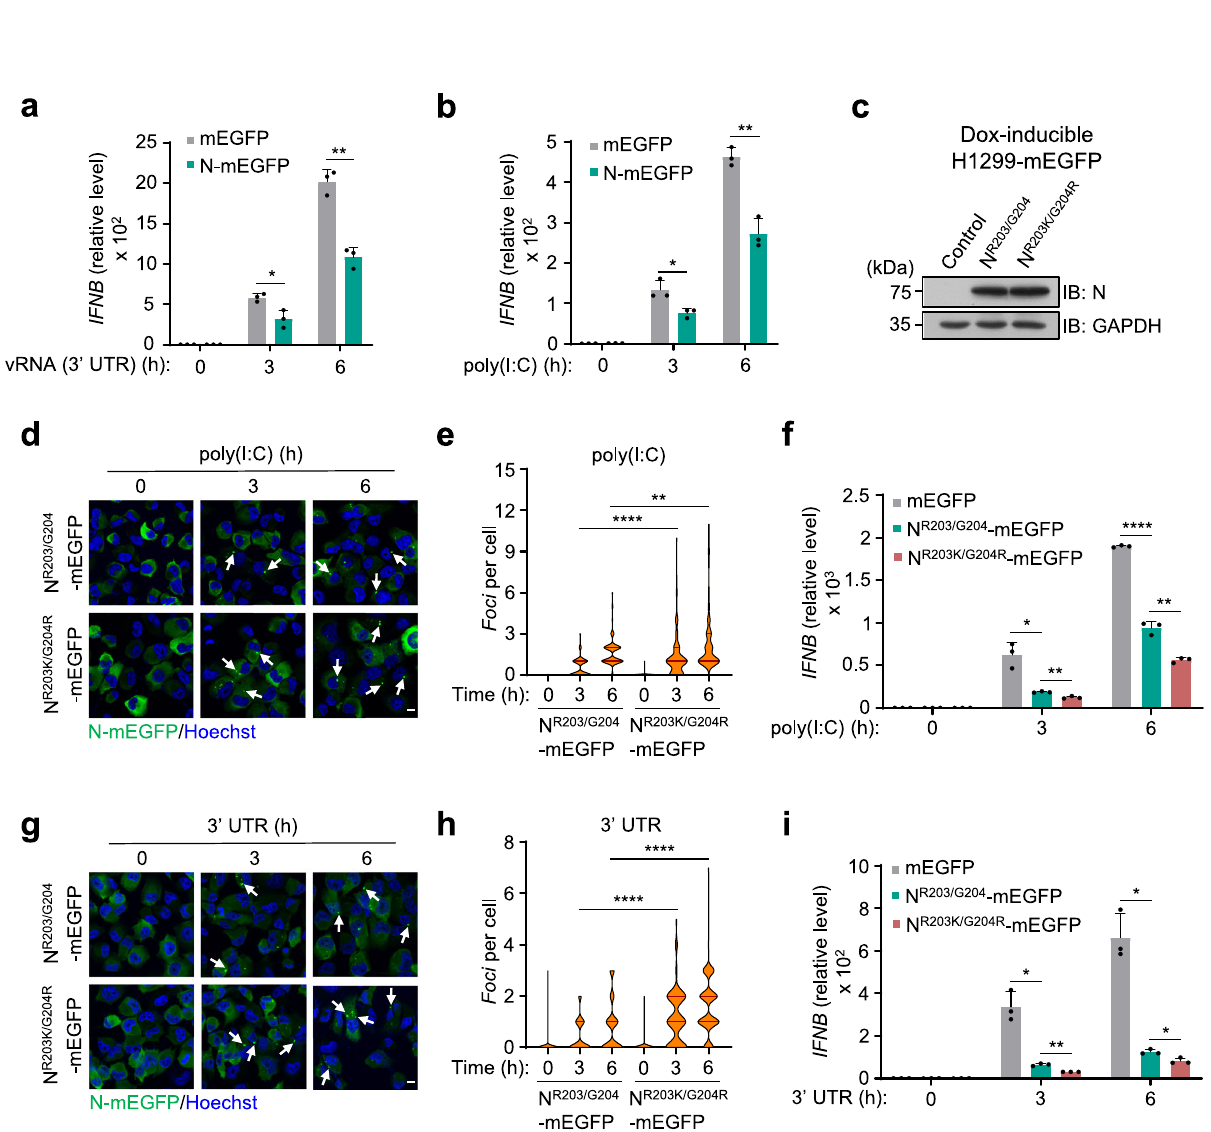
Fig. 5 N inhibits RNA-induced IFN expression. a , b qPCR analysis of IFNB expression in H1299 cells stimulated with 500 ng/ml vRNA (3 ′ UTR) ( a ) or poly (I:C) ( b ), following a 24-h Dox-induced expression of N-mEGFP protein ( n = 3 biologically independent samples). c Immunoblot analysis of the Dox- induced expression of N R203/G204 -mEGFP and N R203K/G204R -mEGFP proteins in H1299 cells. Control, H1299-mEGFP cells. d , e Representative fl uorescent images of H1299 cells stimulated with 1 μ g/ml poly(I:C) ( d ). Foci of N R203/G204 -mEGFP and N R203K/G204R -mEGFP proteins per cell were quanti fi ed, n = 100 biologically independent cells ( e ). f qPCR analysis of IFNB expression in H1299 cells stimulated with 500 ng/ml poly(I:C), n = 3 biologically independent samples. g , h Representative fl uorescent images of H1299 cells stimulated with 3 μ g/ml vRNA (3 ′ UTR) ( g ). Foci of N R203/G204 -mEGFP and N R203K/G204R -mEGFP proteins per cell were quanti fi ed, n = 100 biologically independent cells ( h ). i qPCR analysis of IFNB expression in H1299 cells stimulated with 500 ng/ml vRNA (3 ′ UTR), n = 3 biologically independent samples. Hoechst (blue), nuclear staining ( d , g ). Scale bars, 10 μ m ( d , g ). Violin plots showing foci of cells from each group, lines within the plots, with 25th, 50th, and 75th percentiles marked ( e , h ). Error bars, mean with s.d. ( a , b , f , i ). Two-tailed unpaired Student ’ s t -test ( a , b , e , f , h , i ), * P < 0.05, ** P < 0.01, **** P < 0.0001. Data are representative of at least three independent experiments. Source data are provided as a Source Data fi le.